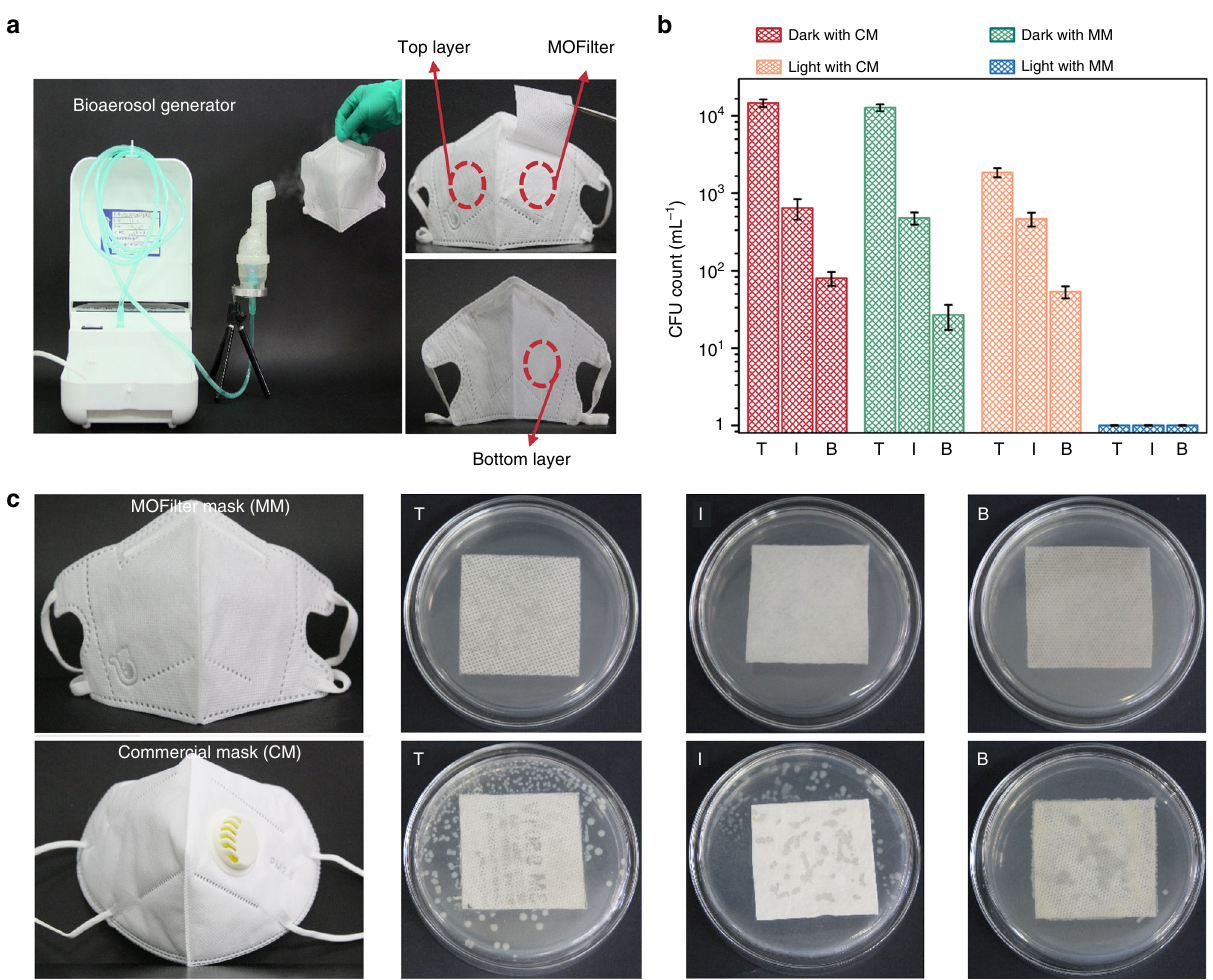
Fig. 5 Antibacterial performance comparison between metal-organic framework (MOF)-based fi lter (MOFilter) mask (MM) and commercial mask (CM). a Bioaerosol generation apparatus and optical images of trilaminar MOFilter mask. b , c Escherichia coli levels residual on top, inner and bottom layers of MM and CM, respectively, after 30 min of light irradiation. The number of viable cells in b is determined from saline eluent used for collecting living bacteria on each layer of mask after reaction. The bacterial colonies residual on eluent-treated mask are shown in c . The top, inner, and bottom layers are denoted as T, I and B, respectively. The error bars are calculated via repeating the measurements for three